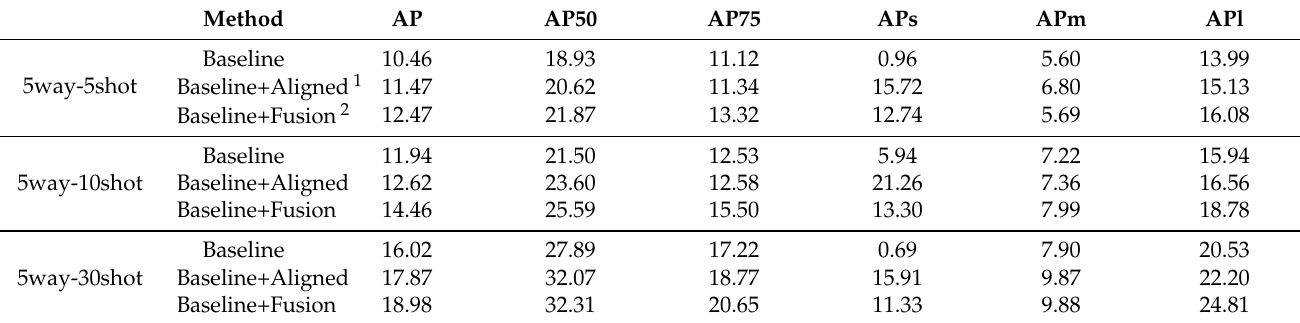
Table 3. Detection result for Aligned Contrastive Loss and Multi-Scale